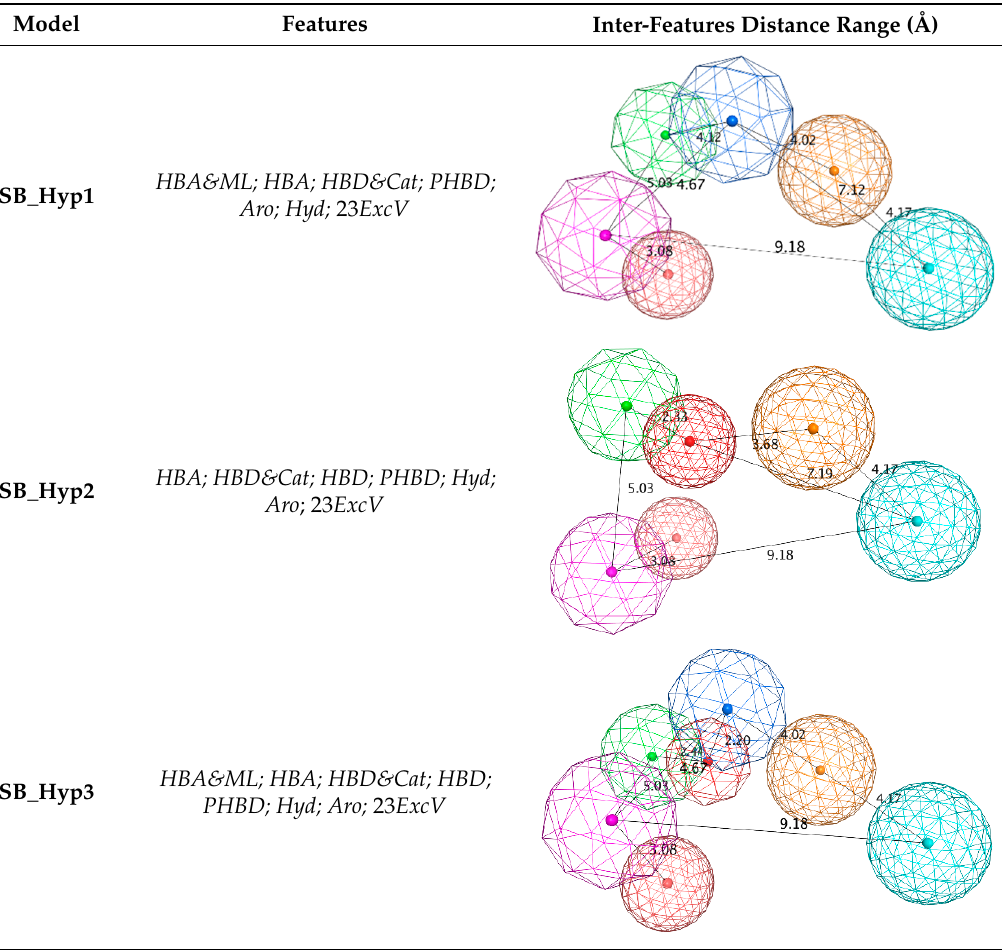
Table 1. Representation of SB pharmacophoric hypotheses and their inter-feature distances. Cyan sphere indicates the feature hydrogen bond acceptor ( HBA ); dark blue sphere represents hydrogen bond acceptor and metal ligation ( HBA&ML ); magenta sphere shows hydrogen bond donor and cation ( HBD&Cat ); red sphere represents hydrogen bond donor ( HBD ); dark magenta color represents projection of hydrogen bond donor ( PHBD ); orange sphere indicates aromatic ( Aro ); and green sphere represents hydrophobic ( Hyd ). The ExcV spheres were removed for better visualization.